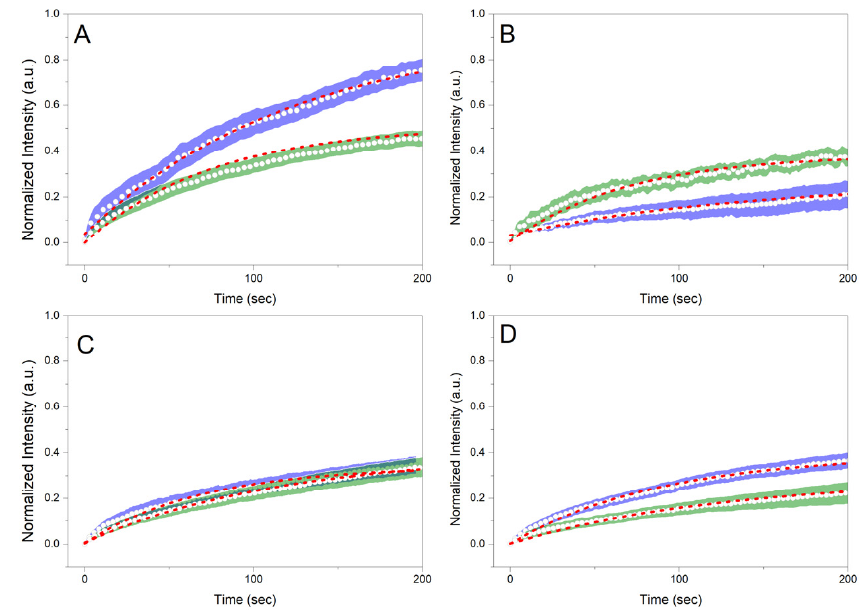
Figure 6. Normalized recoveries (FRAP) plotted against recovery time for ( A ) 20 GMS, ( B ) 20 GMS/1 GMO, ( C ) 20 GMS/2.5 GMO, and ( D ) 20 GMS/5 GMO samples. Green and blue highlighted curves represent samples before and after the whipping process, respectively. Red highlighted curves represent the fitted exponential model.